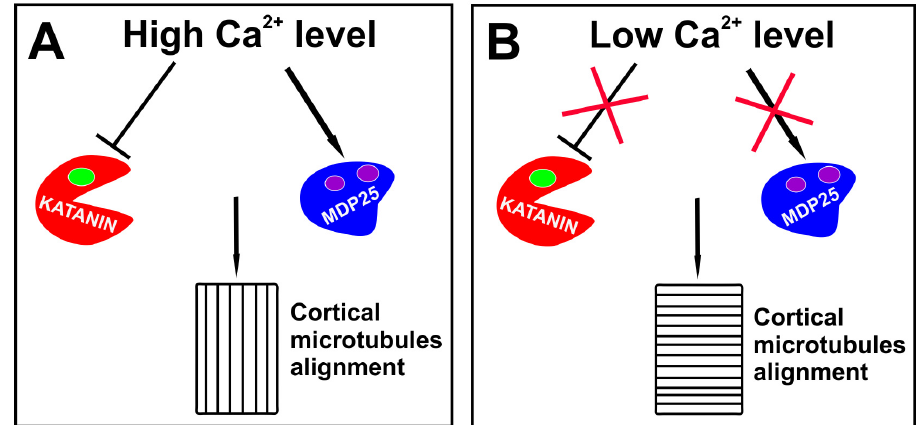
Figure 1. The role of calcium ions in the regulation of the direction of cell division during embryogenesis. ( A ) A high concentration of calcium ions negatively regulates functioning of katanin and activate destabilizing properties of MDP25, finally supporting longitudinal alignment of microtubules. ( B ) Low concentration of calcium ions has limited impact on katanin or MDP25. In this situation katanin activity is maintained and function of MDP25 is stopped, which results in transverse alignment of microtubules.